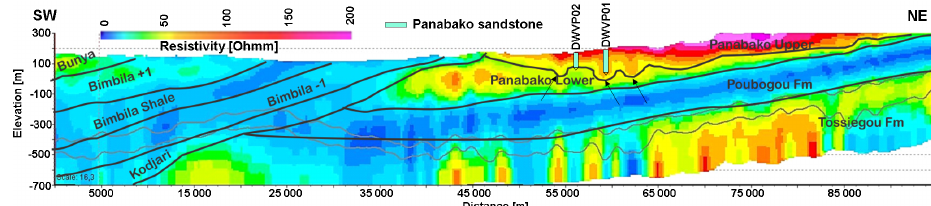
Figure 7. Cross section along SW–NE line 2 across the study area (see Fig. 1a for the location) with the conceptual geological interpretations showing the U-shaped valleys (between 53 and 63km, whose location is indicated by three black arrows). In addition, two of the geologic logs (DWVP02 and DWVP01; Fig. 1a) used for the demarcation of lithostratigraphic boundaries and the interpretation and/or verification of the geophysical model are also shown. The two solid grey lines at the bottom represent the